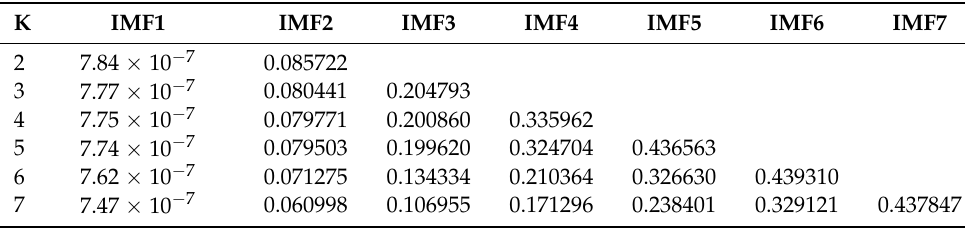
Table 3. Central frequency for the IMF components of the first set of